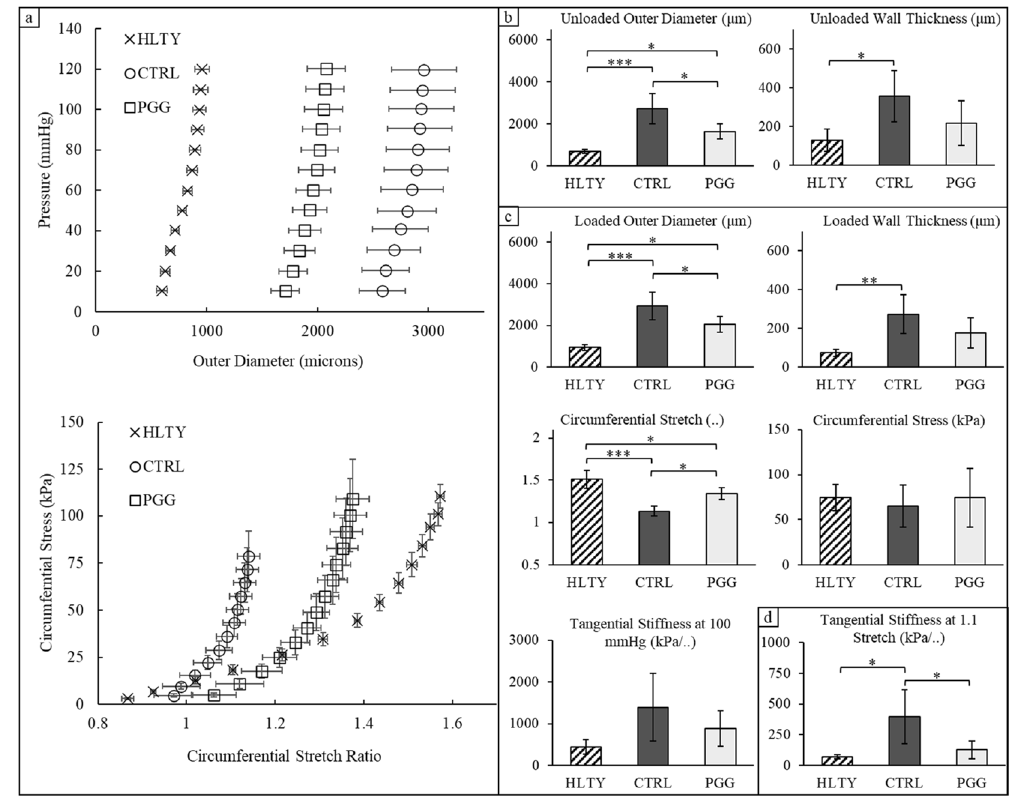
Figure 8. Ex vivo mechanical testing of aneurysmal aortas. Tissues were taken from age-matched healthy (HLTY; n = 5), Ang-II infused aneurysmal controls (CTRL; n = 5), and Ang-II infused aneurysmal pentagalloyl glucose (PGG-NPs; n = 5)-treated animals. ( a ) Pressure-outer diameter and stress-stretch curves measured during continuous inflation- extension testing. Discrete values of tissues in the ( b ) unloaded state, ( c ) physiologically loaded state, and ( d ) at a common stretch ratio. Scatter-plots are mean ± SEM and bar charts (b-d) are mean ± STD. ***p < 0.01, **p < 0.05, *p <